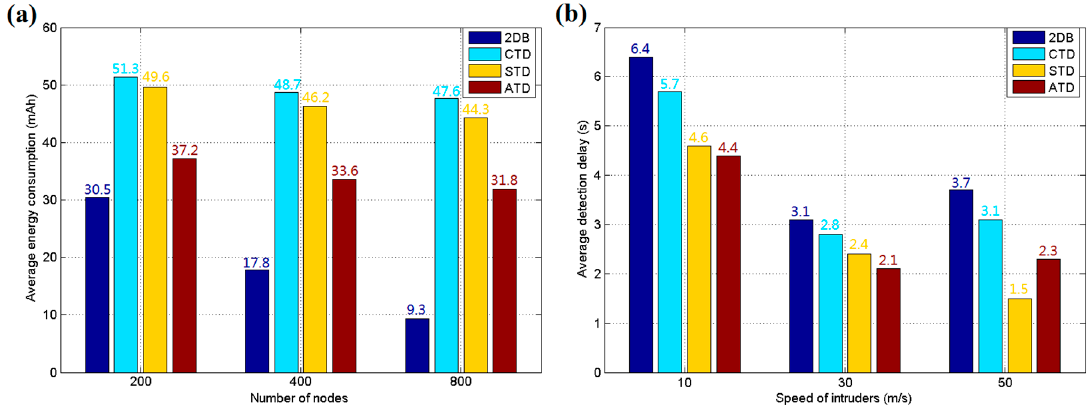
Figure 9. ( a ) Average energy consumption of each sensor node in an hour; and ( b ) average detection delay for each method.